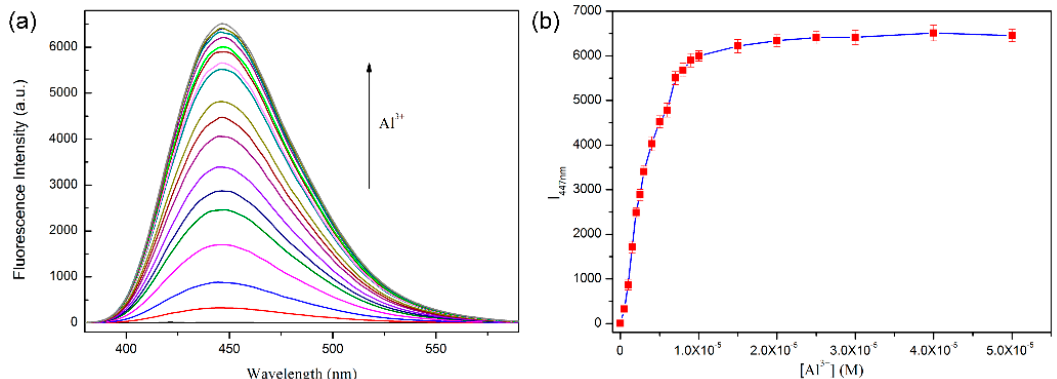
Figure 3. ( a ) Fluorescence spectra of PEGBAB (10 μ M) with the increasing concentration of Al 3+ (0–50 μ M) in aqueous solution. ( b ) Plot of fluorescence intensity at 447 nm against the concentration of Al 3+ .